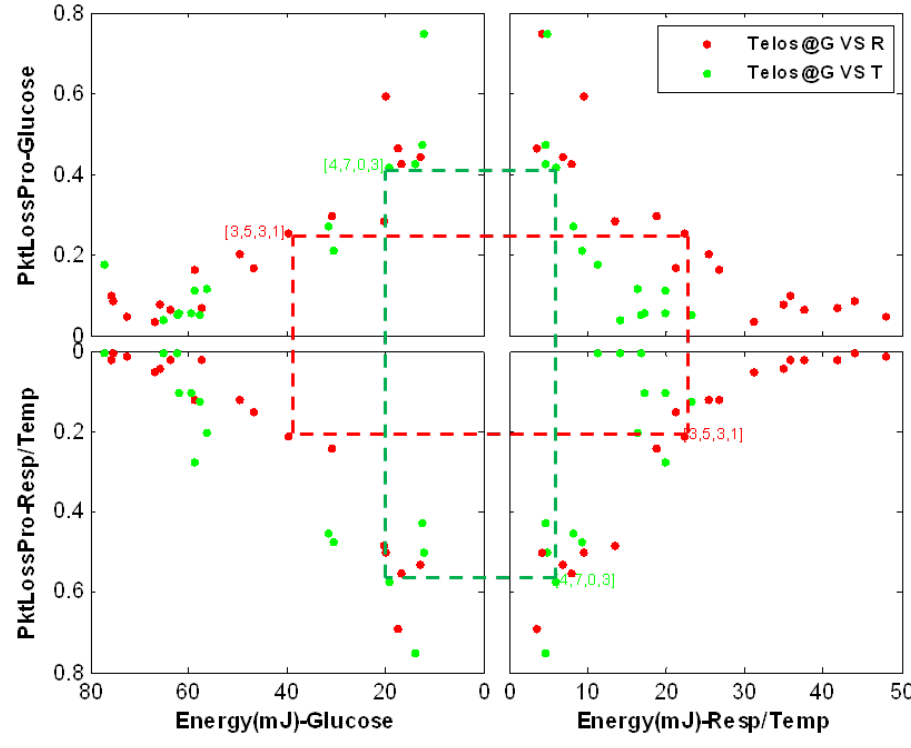
Figure 8. Energy and packet loss Pareto front (Glucose vs.